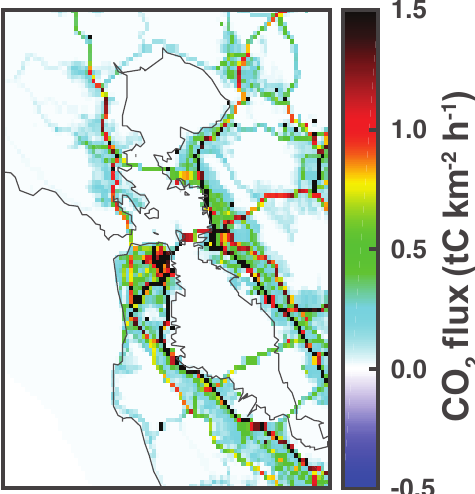
Figure 3. A sample high-resolution bottom-up emissions inventory for the Bay Area adapted from Turner et al.